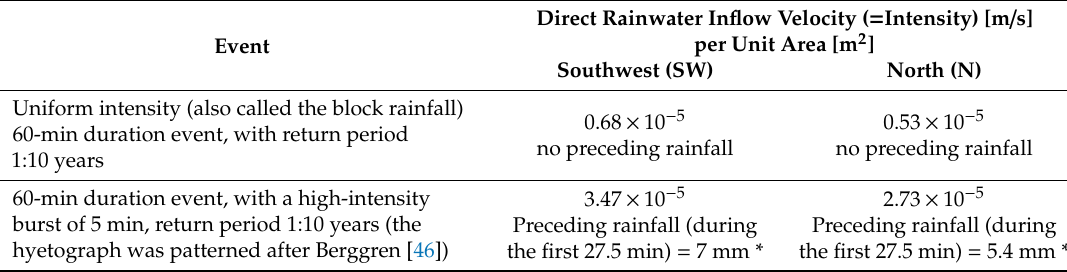
Table 3. Direct inflow of rainwater into